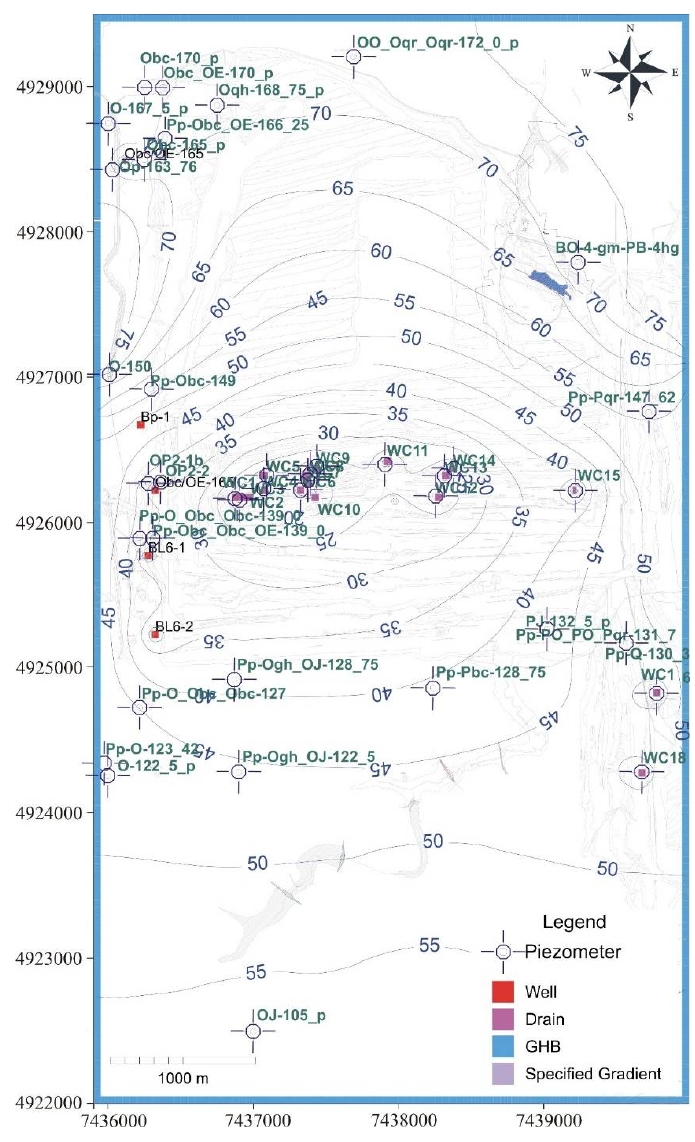
Figure 11. Groundwater levels of the lower aquifer (7th model layer)–April 2014.